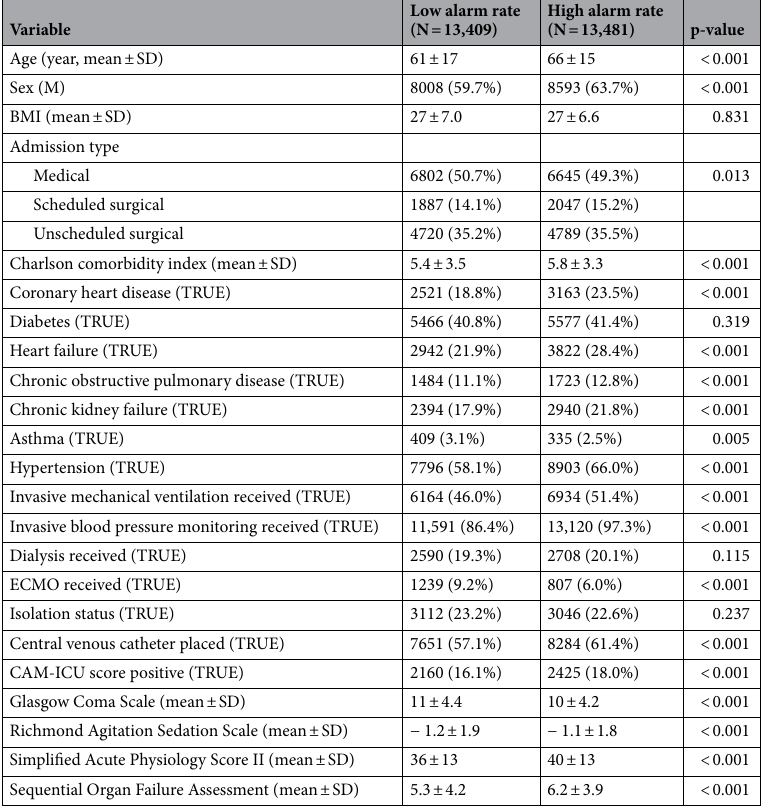
Table 1. Characteristics of patients with a low and high alarm rate. BMI, body mass index; ECMO, extracorporeal membrane oxygenation; CAM-ICU, confusion assessment method for the